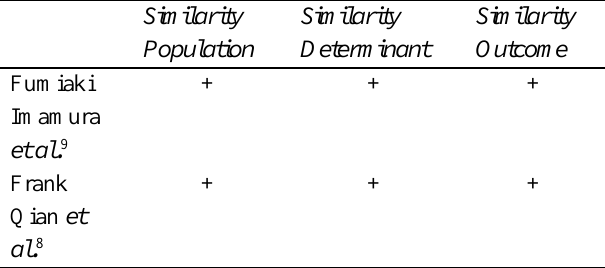
Table 4 The Similarity of Articles with